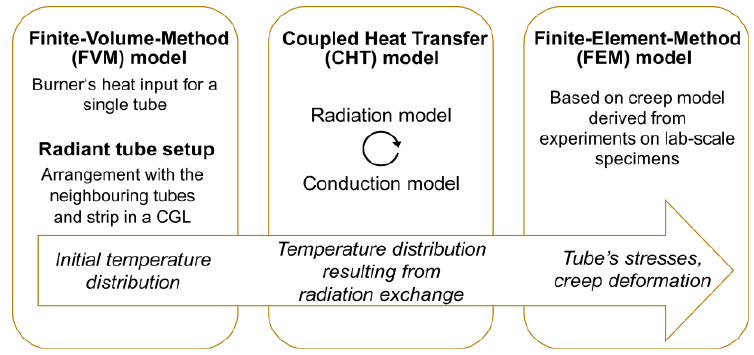
Figure 4. Working principle of the coupled heat transfer (CHT) model as part of a fluid-structure- interaction (FSI) approach.